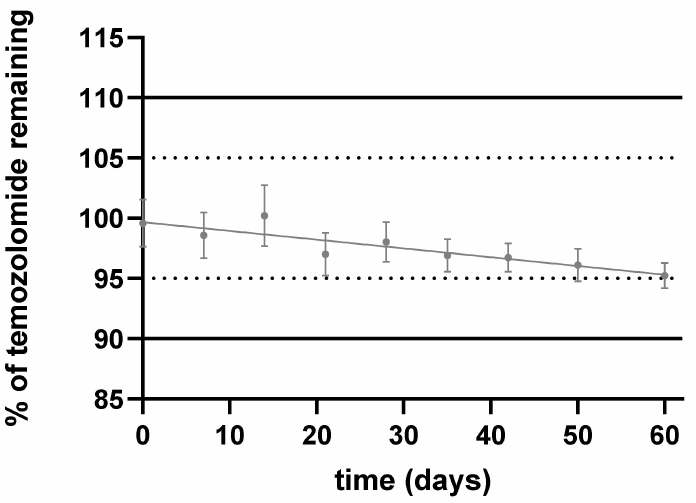
Figure 2. Chemical stability of TMZ suspension stored at + 2–8 ◦ C and protected from the